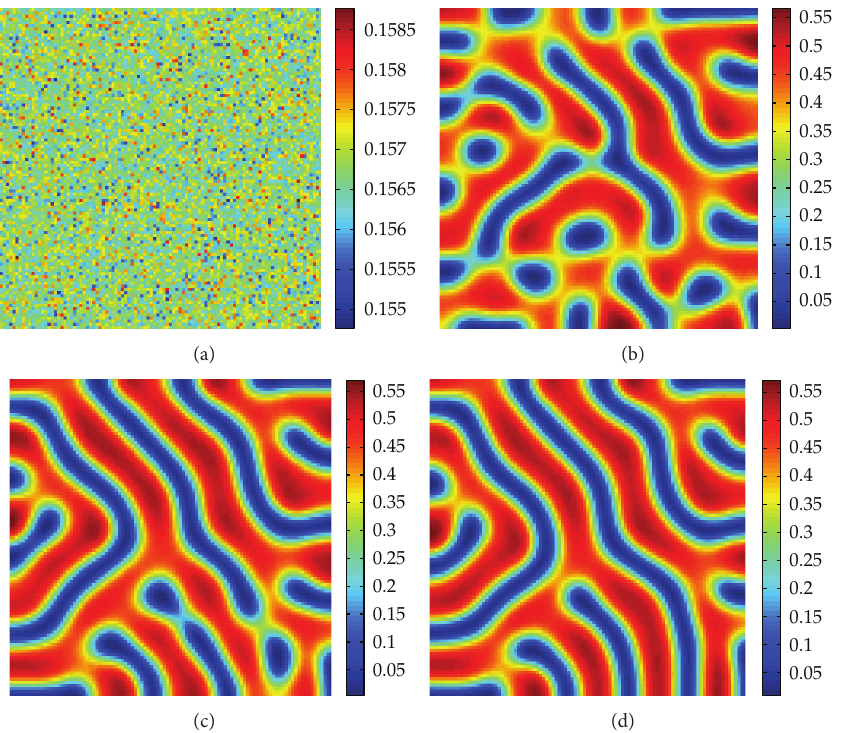
Figure 3: Stripes pattern formation for model (5) by taking (𝑏,𝑠) = (0.8, 2) . Iterations: (a) 0 ; (b) 0.5 × 10 5 ; (c) 1.5 × 10 5 ; (d) 3 × 10 5